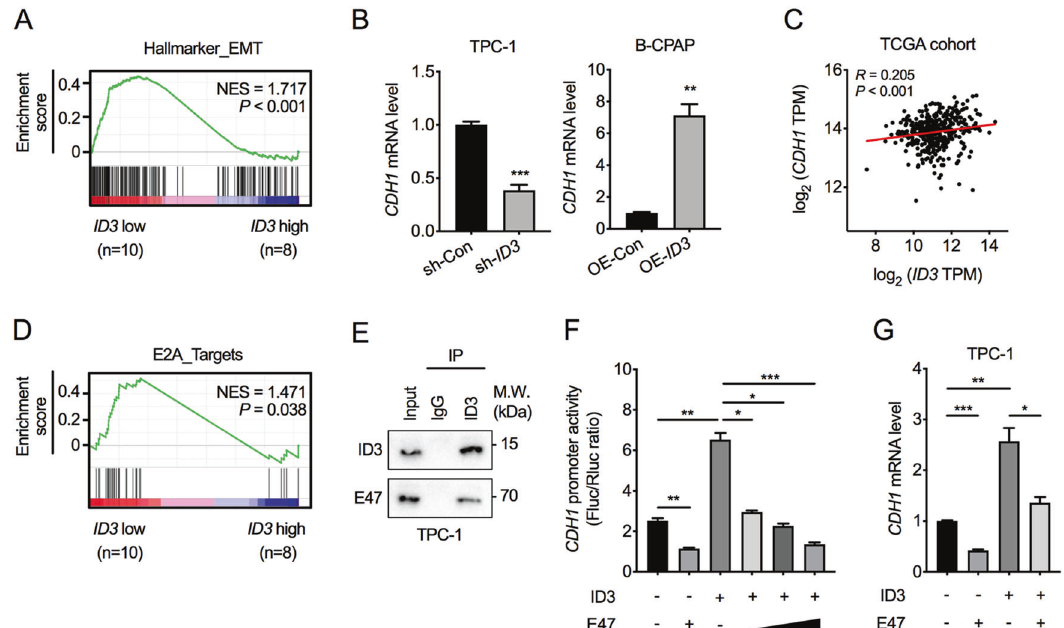
Fig. 4 ID3 interacts with E47 to regulate CDH1 expression. A Gene set enrichment analysis (GSEA) result of EMT signature in ID3-low ( n = 10) versus ID3-high ( n = 8) expression in GSE64912 dataset. B CDH1 mRNA levels in ID3 knockdown TPC-1 cells or ID3 overexpression B-CPAP cells, expressed relative to corresponding control cells. Bar, SD. ** P < 0.01, *** P < 0.001. C The Pearson correlation coef fi cient analysis of transcriptional levels between ID3 and CDH1 in PTC tissues from TCGA cohort. D GSEA result of E2A target gene signature in ID3-low ( n = 10) versus ID3-high ( n = 8) expression in GSE64912 dataset. E The interaction of endogenous ID3 protein and E47 protein was identi fi ed by immunoprecipitation. F The activity of CDH1 promoter affected by ID3 or E47 was measured by dual-luciferase assays. Bar, SD. * P < 0.05, ** P < 0.01, *** P < 0.001. G CDH1 mRNA levels in TPC-1 cells transfected with ID3 and (or) E47. Bar, SD. * P < 0.05, ** P < 0.01, *** P <